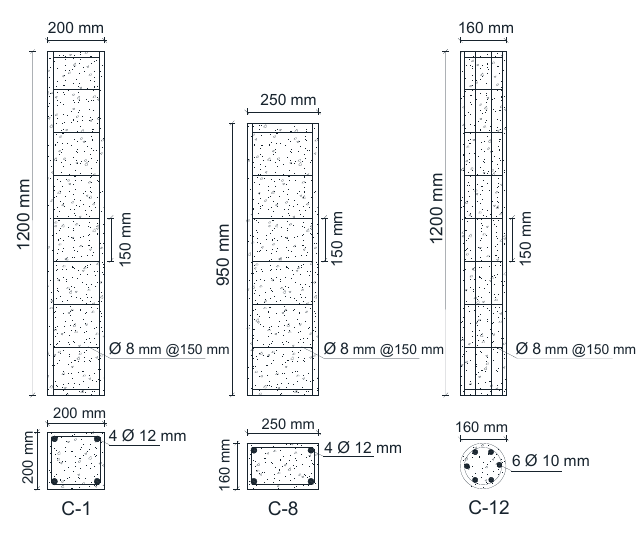
Figure 1. Geometric details of the RC columns.